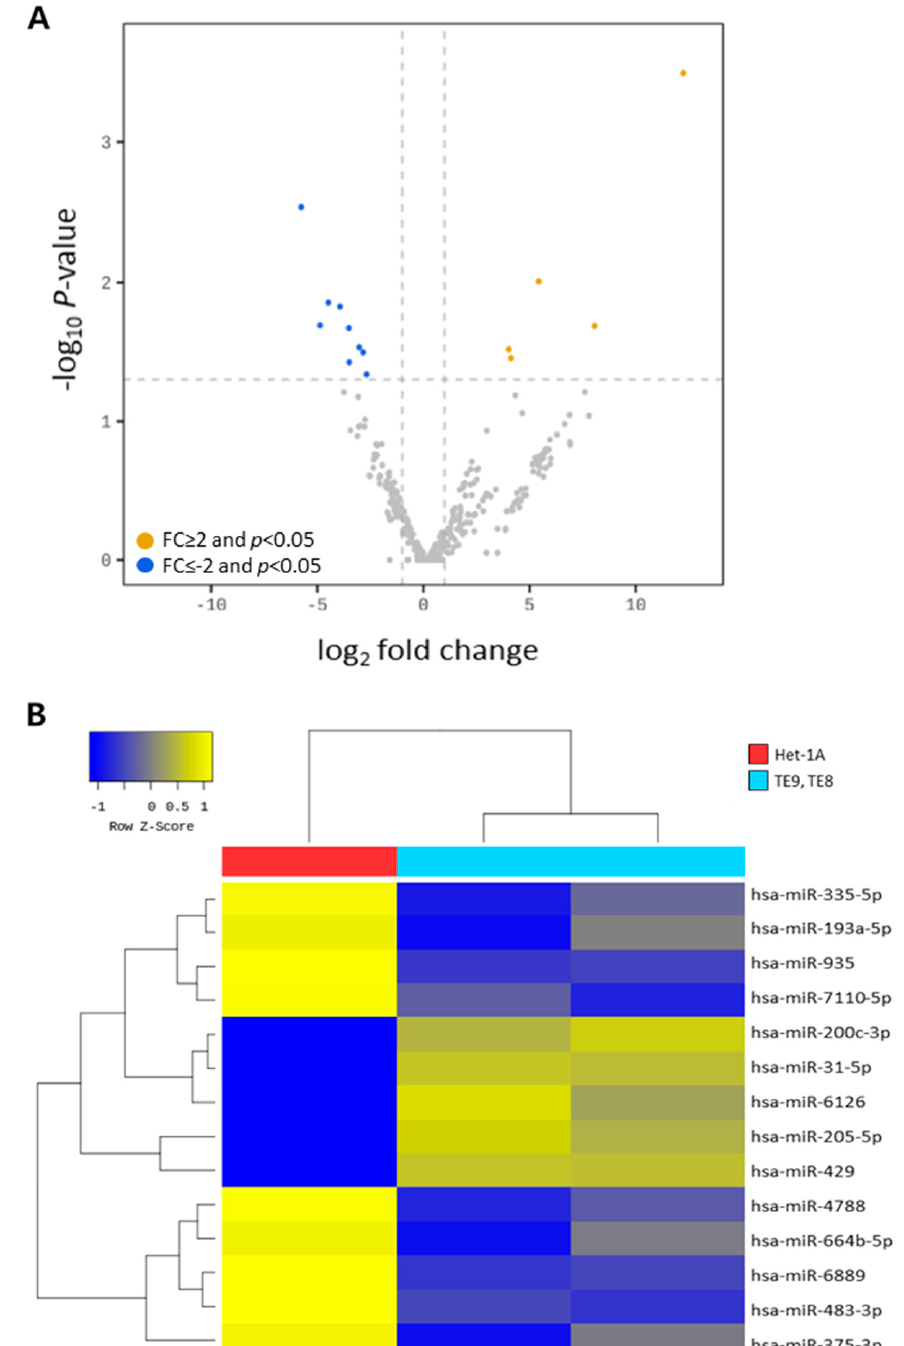
Figure 4. Differentially expressed exosomal miRNAs between esophageal epithelial cell and esophageal squamous cell carcinoma cell lines. ( A ) Volcano plots of differentially expressed exosomal miRNAs. Colored circles represent miRNAs significant at |fold change (FC)| ≥ 2 and p < 0.05. Orange dot, up-regulated; blue dot, down-regulated. ( B ) Heatmap of hierarchical clustering based on 14 differentially expressed exosomal miRNAs (five up-regulated and nine down-regulated). Samples with similar miRNA expression were